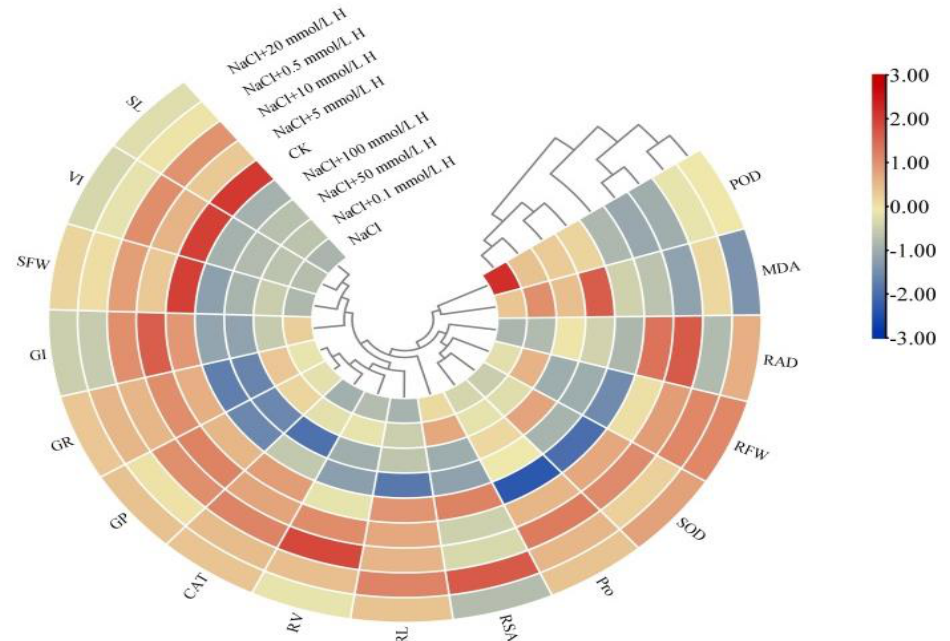
Figure 5. Hierarchical cluster analysis among various salt tolerance indices under different treatments. CK, control treatment (only water); NaCl, 50 mmol L − 1 NaCl treatment; NaCl + xxx H, treatments of standard NaCl + respective H 2 O 2 concentration.